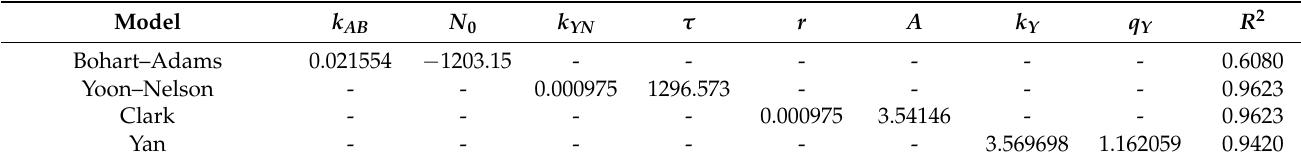
Table 2. Fixed-bed biosorption column model